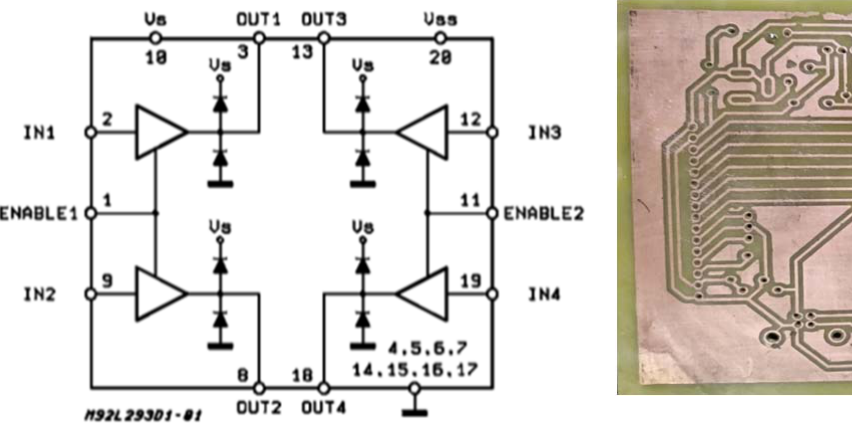
Figure 3. Representation of motor driver ckt block diagram.